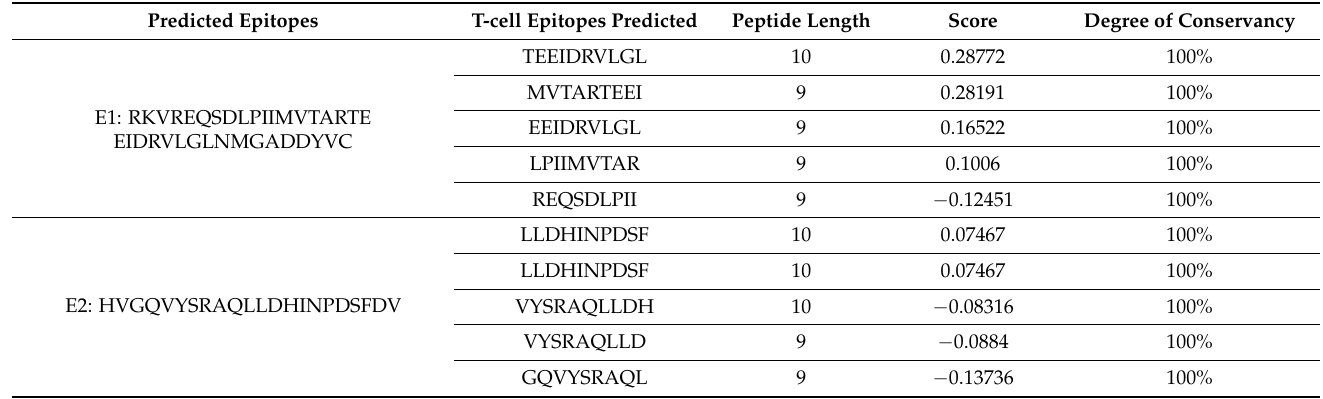
Table 5. Class I immunogenicity predictions of BaeR epitopes with positive values, as an indication of their ability to elicit an immune response and degree of conservancy.